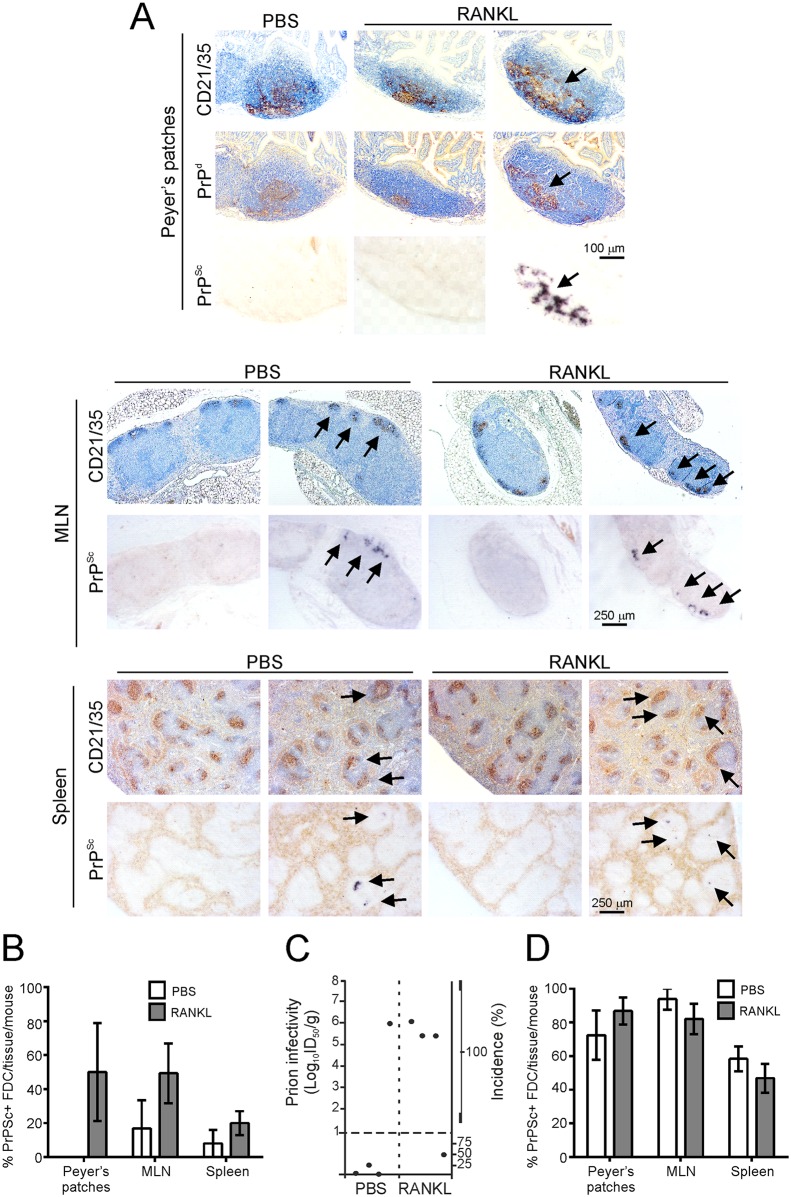
RANKL-treatment induces the earlier accumulation of prions in lymphoid tissues after oral exposure.C57BL/6 mice were treated daily for 4 d with RANKL (or PBS as a control) to induce M cell-differentiation, and orally-exposed to a moderate (1%) dose of ME7 scrapie prions between the 3rd and 4th treatments. Peyer’s patches, mesenteric lymph nodes (MLN) and spleens were collected at 70 and 105 days post infection (dpi). A) At 70 dpi, abundant accumulations of PrPSc (PET immunoblot, black, arrows) were clearly evident in association with FDC (CD21/35+ cells, brown, arrows) in the Peyer’s patches, MLN and spleens of many of the RANKL-treated mice, but were undetectable in the majority of the tissues from the PBS-treated mice. Sections were counterstained with haematoxylin to detect cell nuclei (blue). B) At 70 dpi, the frequency of FDC networks containing PrPSc was increased in the Peyer’s patches, MLN and spleens of the RANKL-treated mice when compared to PBS-treated control mice (n = 4 mice/group). C) Prion infectivity levels were assayed in spleens from RANKL-treated and PBS-treated control mice (n = 4 spleens/group) collected at 70 dpi. Prion infectivity titres (log10 ID50/g tissue) were determined by injection of tissue homogenates into groups of tga20 indicator mice (n = 4 recipient mice/spleen). Each symbol represents data derived from an individual spleen. Data below the horizontal line indicate disease incidence in the recipient mice <100% and considered to contain trace levels of prion infectivity. D) At 105 dpi, no difference in the frequency of FDC networks containing PrPSc was observed in the Peyer’s patches, MLN and spleens of mice from each treatment group (n = 4 mice/group).